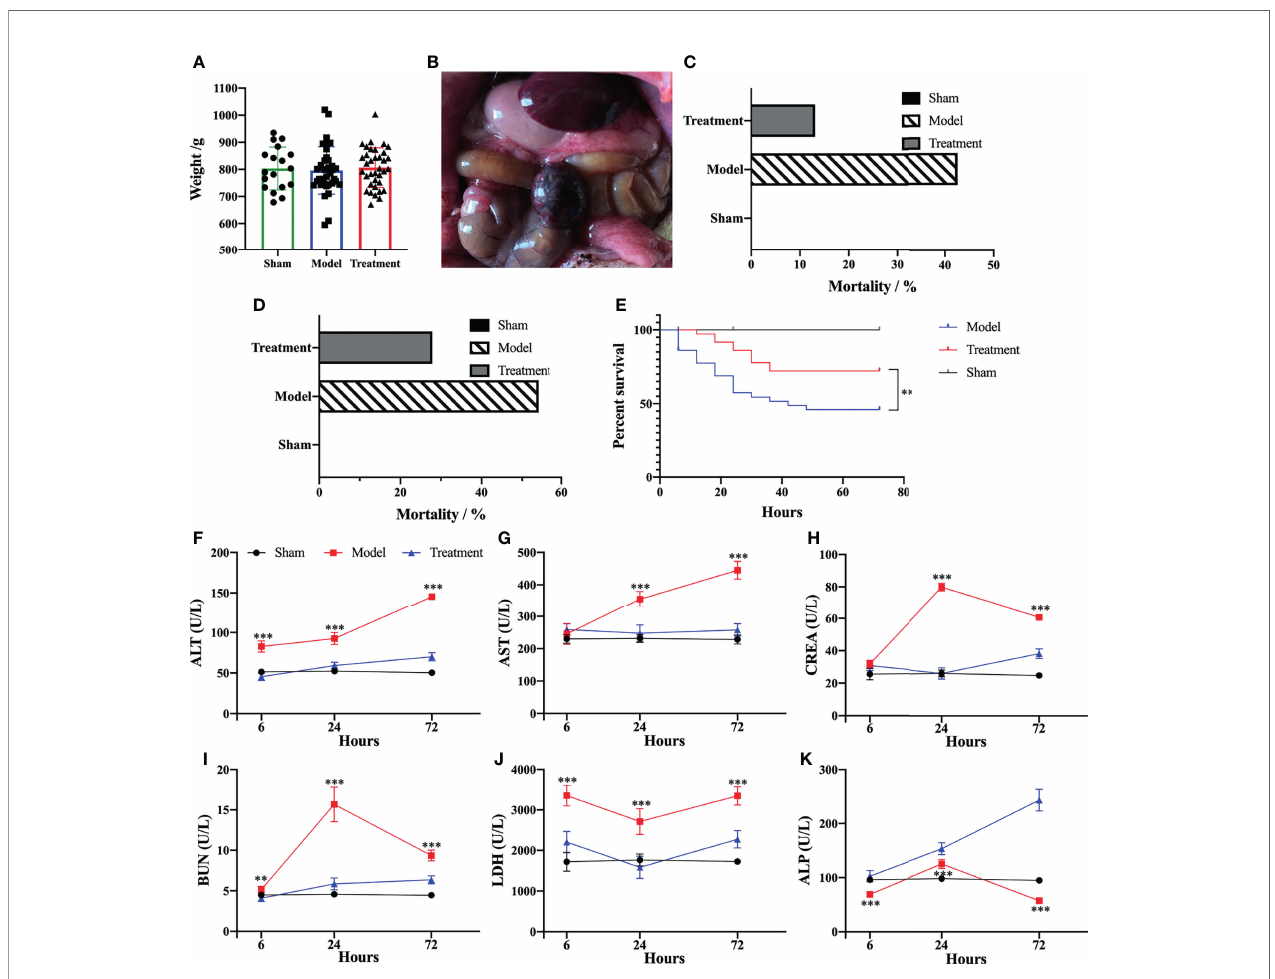
FIGURE 1 | Survival rate and biochemical markers of rats in each group. (A) Mean body weight of rats in each group; (B) Hemorrhagic necrosis of cecum and abdominal bulk of rats after CLP; (C) 24h mortality rate of rats in each group; (D) 72h mortality rate of rats in each group; (E) survival analysis of rats in each group [Log-rank (Mantel-Cox) Test]; (F – K) levels of biochemical markers in serum of rats in each group. n=5, **p<0.01,